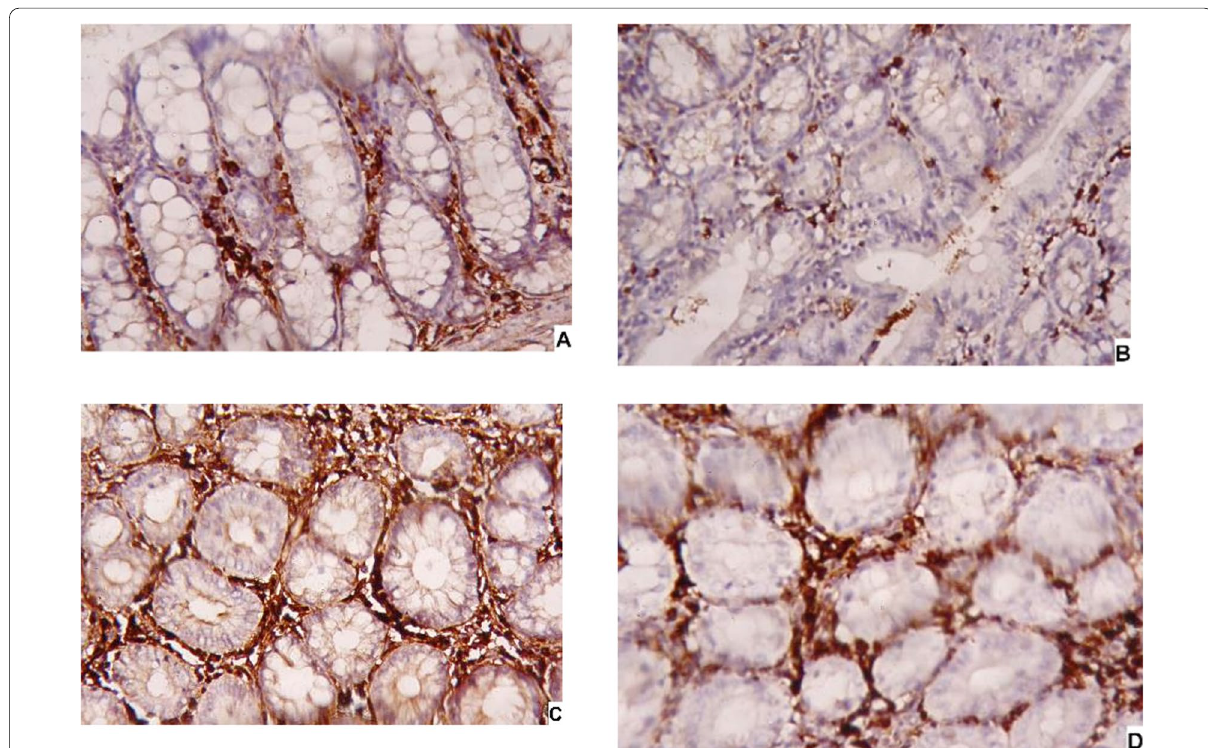
400). A : Control group showed moderate nuclear ×